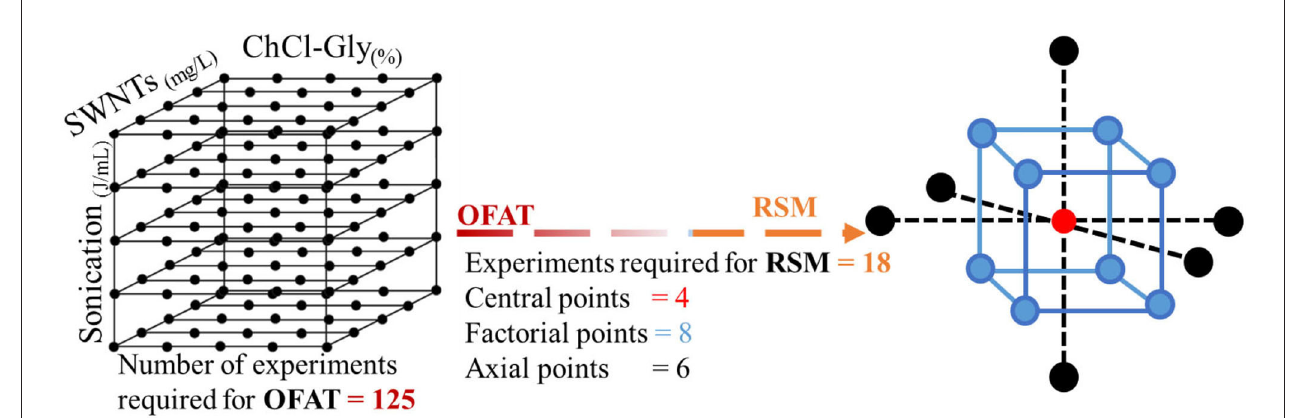
FIGURE 1 | (LHS) One factor at a time (OFAT) for three variables [A: ChCl-Gly (mass% in water), B: SWNTs’ concentration (mg/L), and C: Sonication energy (J/mL)] at five levels require 5 3 ( = 125) experiments without replicates. (RHS) Response surface methodology (RSM) reduces the number of experiments to 18 only. The circular points (at center, corners, and parallel to the face of the cube) represent the experimental runs. Central composite rotatable design (CCRD) of RSM, representing experimental points in the design space for three variables, is capable of navigating through the design space which is not possible with OFAT.